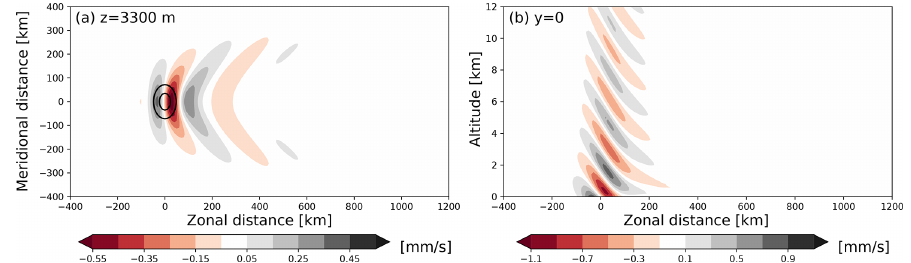
Figure 10. Linear stationary inertia–gravity wave response to the forcing from isolated orography. Shading and contours are the same as in each row of Fig. 9 except that the shading shows the Cartesian vertical wind (in mms − 1